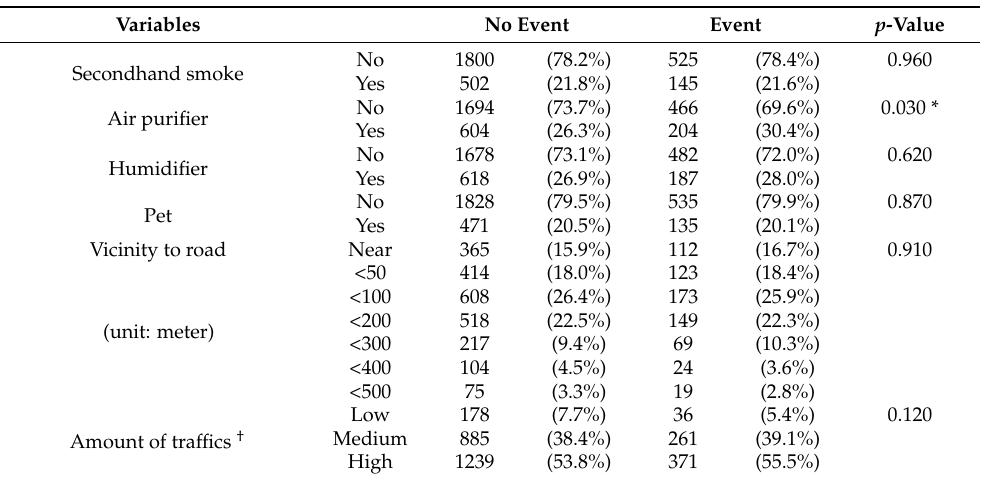
Table 2. Demographic features of the subjects focused on environmental or extrinsic